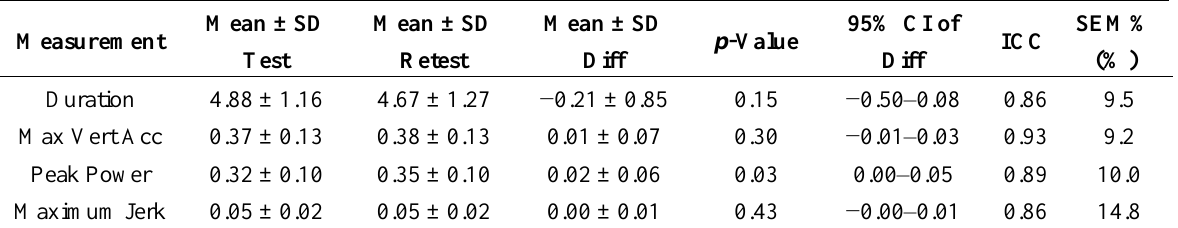
Table 3. Test-retest reliability analysis based on average scores of measurements over all tests. All measurement scores are dimensionless